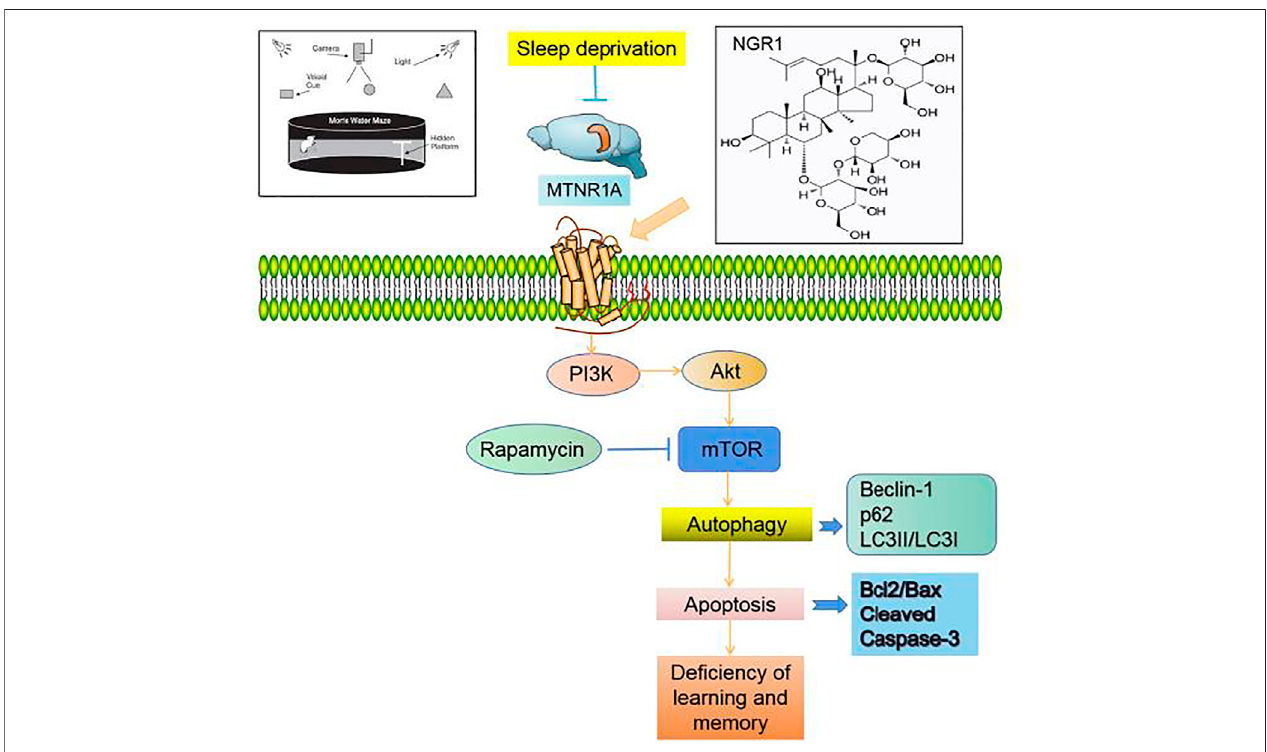
FIGURE 7 | Notoginsenoside R1 reverses abnormal autophagy in hippocampal neuron of mice with sleep deprivation through melatonin receptor 1A.